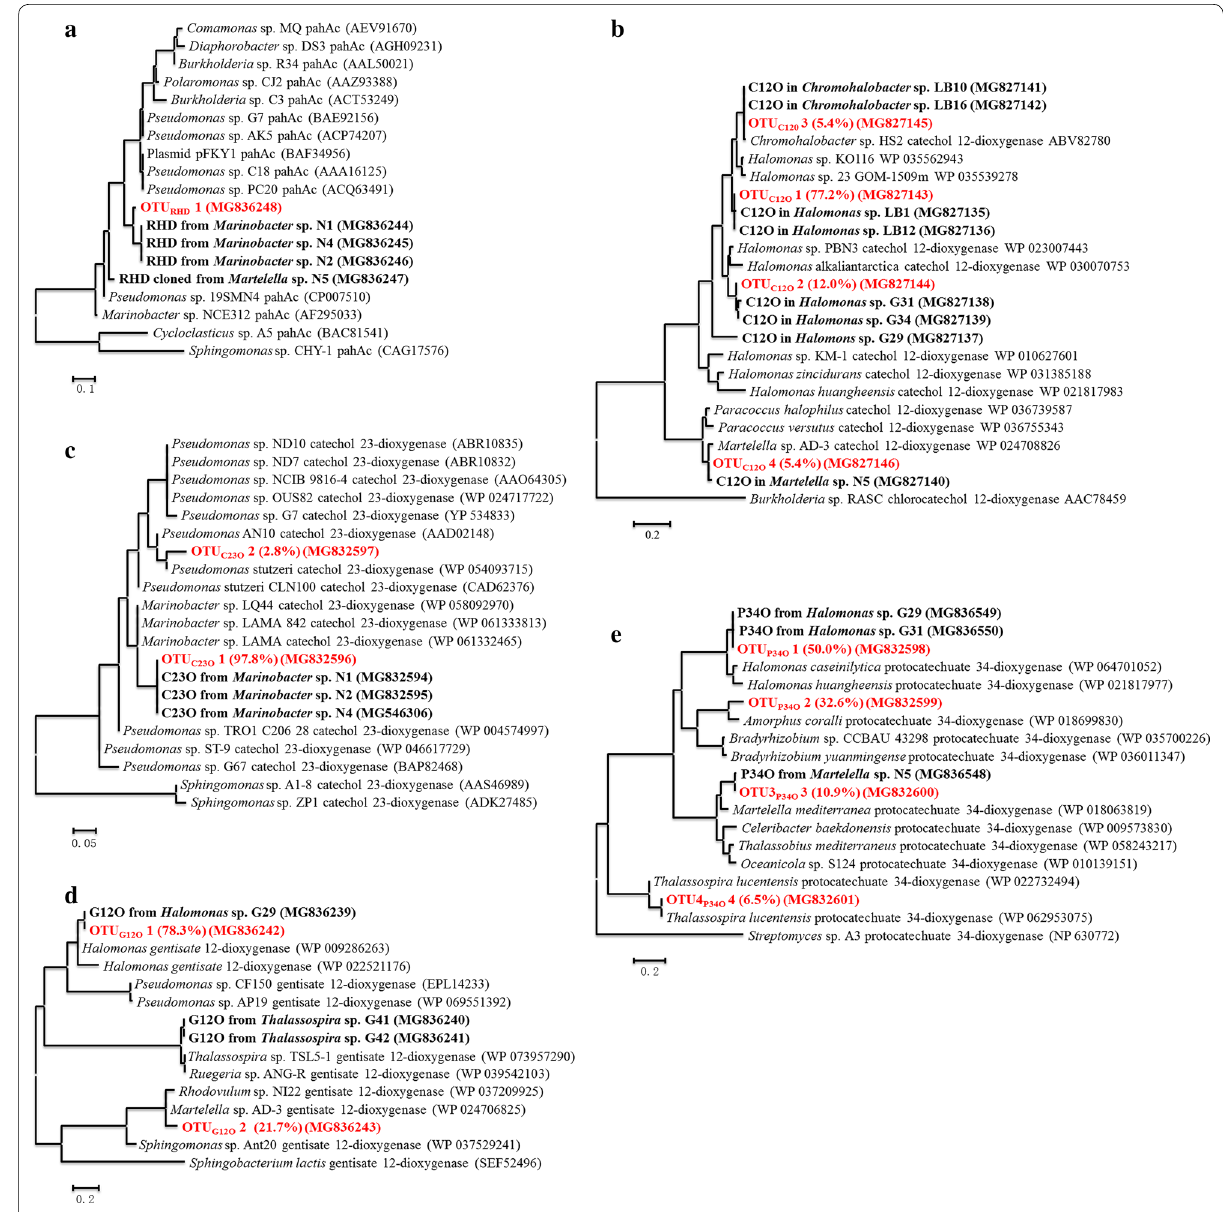
Fig. 4 Phylogenetic trees of catabolic gene fragments obtained from clone libraries and isolated pure cultures. a Genes encoding RHDs; b genes encoding C12Os; c genes encoding C23Os; d genes encoding G12Os; e genes encoding P34O. The sequences obtained from clone libraries were separated into different OTUs with 90% identity. Each OTU was shown in red bold, with proportion shown in the brackets. The sequences of frag- ments obtained from isolated pure cultures were shown in black